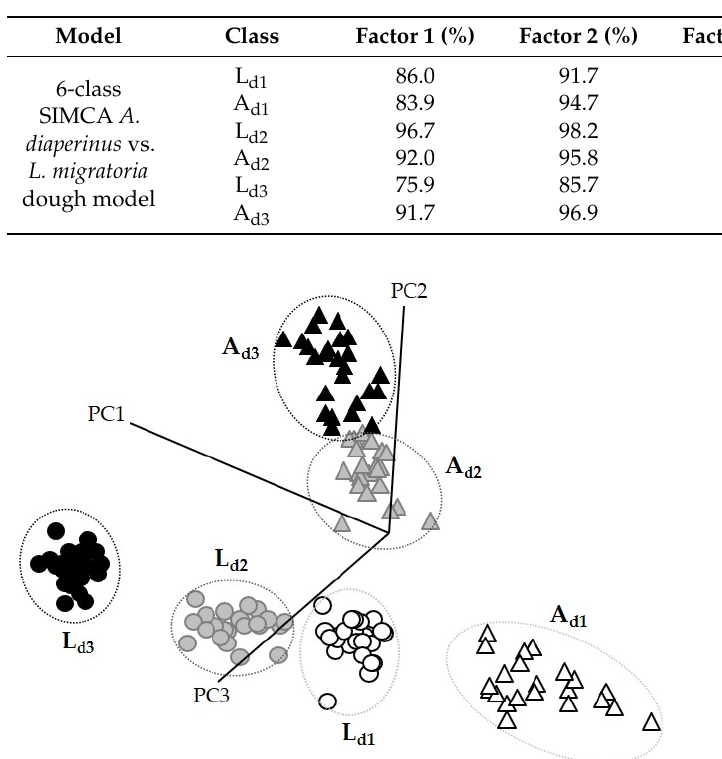
Figure 6. Soft independent modeling of class analogy class projection of FTIR spectroscopy spectra (3000–2700 cm − 1 and 1800–1200 cm − 1 ) from a 6-class SIMCA A. diaperinus vs. L. migratoria dough model. Abbreviations used: A d1 , dough with 4.6% of A. diaperinus powder; A d2 , dough with 9.3% of A. diaperinus powder; A d3 , dough with 13.9% of A. diaperinus powder; L d1 , dough with 4.6% of L. migratoria; L d2 , dough with 9.3% of L. migratoria; L d3 , dough with 13.9% of L. migratoria.